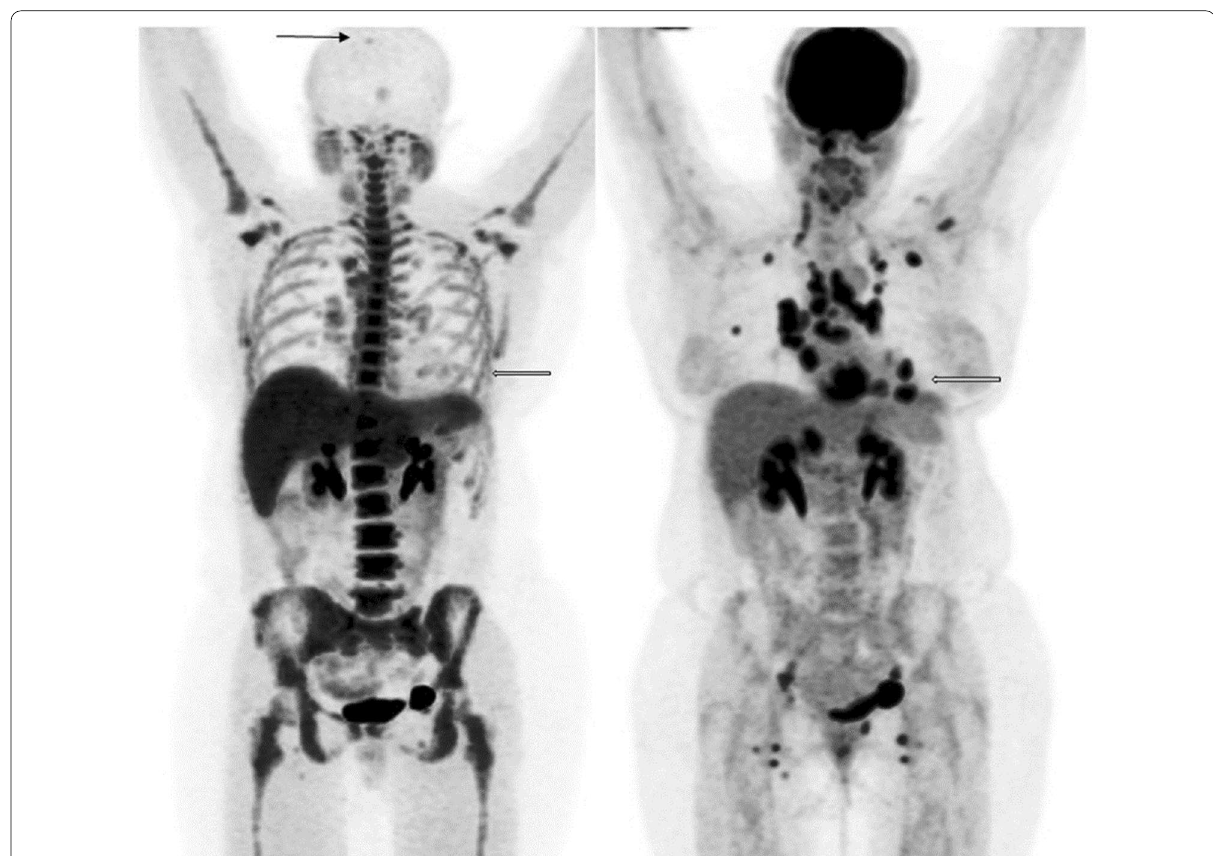
Fig. 1 Whole‑body maximum intensity projections of FLT‑PET (left) and FDG‑PET (right) studies in the same subject (subject #4) with evidence of sarcoidosis, including cardiac and neural involvement (arrows)